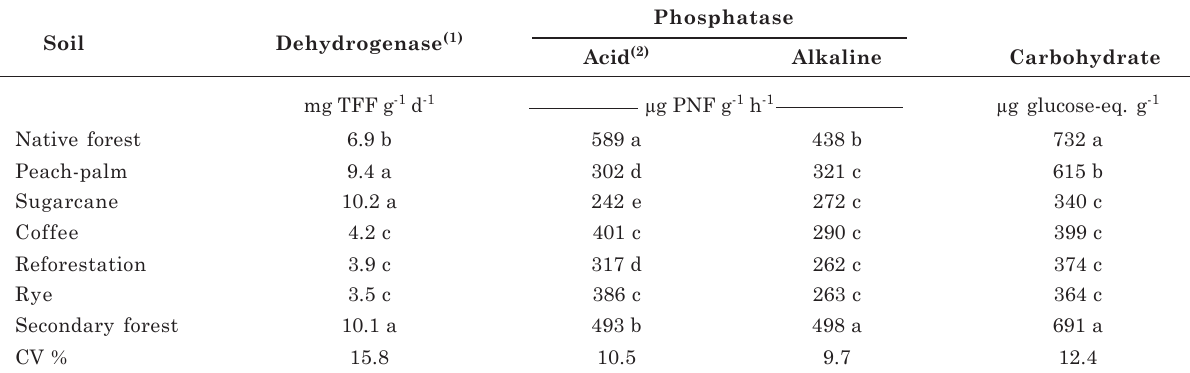
Table 4. Activity of dehydrogenase, acid and alkaline phosphatases, and concentration of hot-water-soluble carbohydrates in a clay soil under different types of management and plant